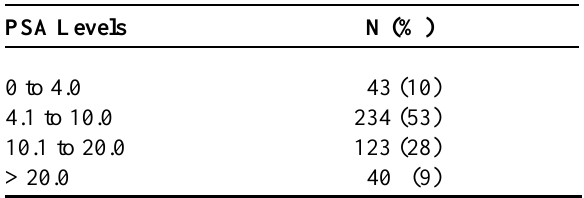
Table 2 – Patient distribution according to pre-operative